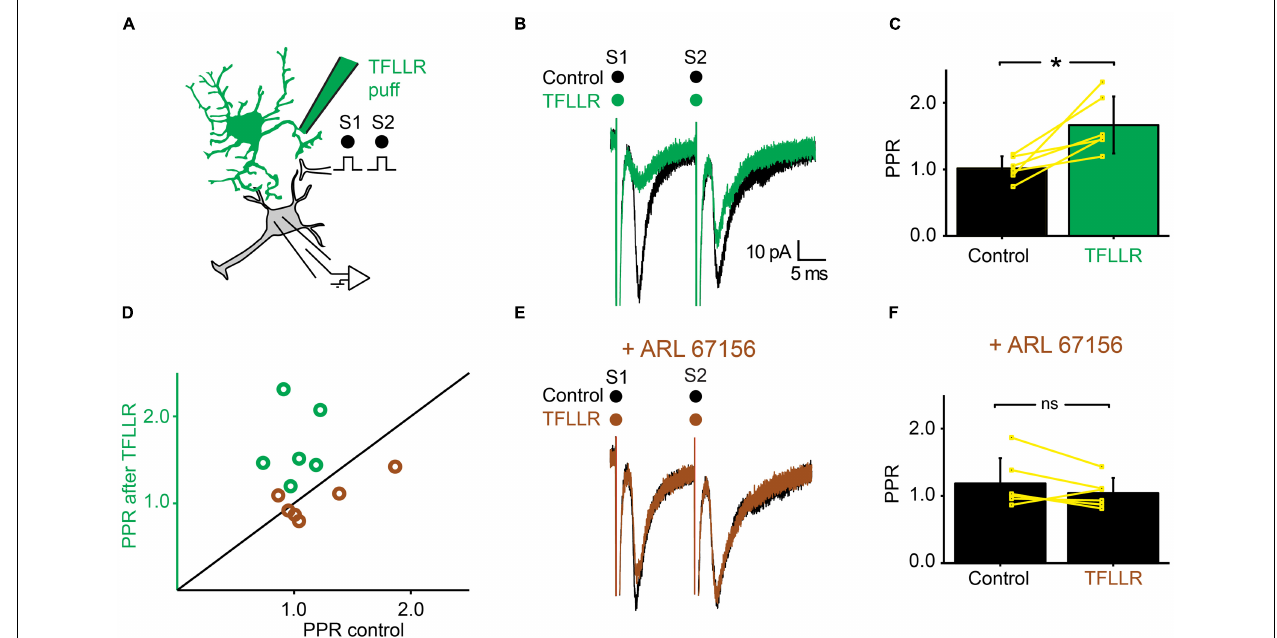
FIGURE 6 | Inhibiting extracellular ectonucleotidases blocks the effects of TFLLR. (A) Schema of the principle of the preparation. Ventral horn neuron recorded in whole-cell mode. Synaptic stimulation produced by a bipolar electrode (S1, S2). Puff application of TFLLR. (B) Response of a ventral horn neuron to two stimulations in control conditions (black) and after puffing TFLLR between the stimulation and recording electrode (green). The amplitude of the first EPSC was decreased. (C) Mean values of the PPR before and after puffing TFLLR. ∗ p < 0.05. (D) PPR